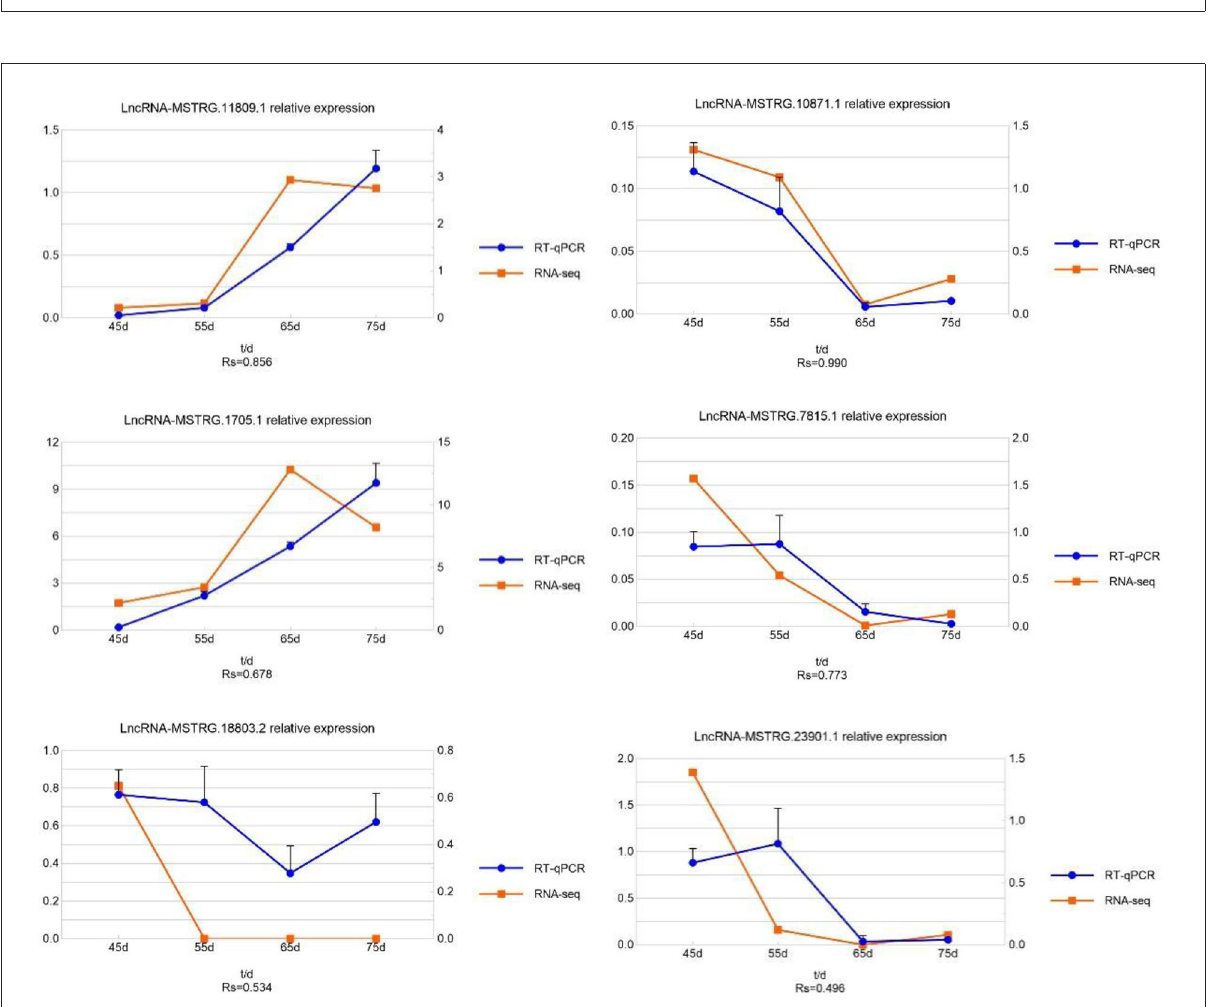
FIGURE7 The expression quantity and expression trend of lncRNA in different periods. A total of 0.8 < | Rs| < 1 indicates a strong correlation; 0.6 < | Rs| < 0.8 indicates a strong correlation; 0.4 < | Rs| < 0.6 indicates a moderate correlation; 0.2 < | Rs| < 0.4 indicates a weak correlation; 0 < | Rs| < 0.2 indicates no correlation; and the degree of proximity between | Rs| and 1 represents the degree of closeness and correlation between two